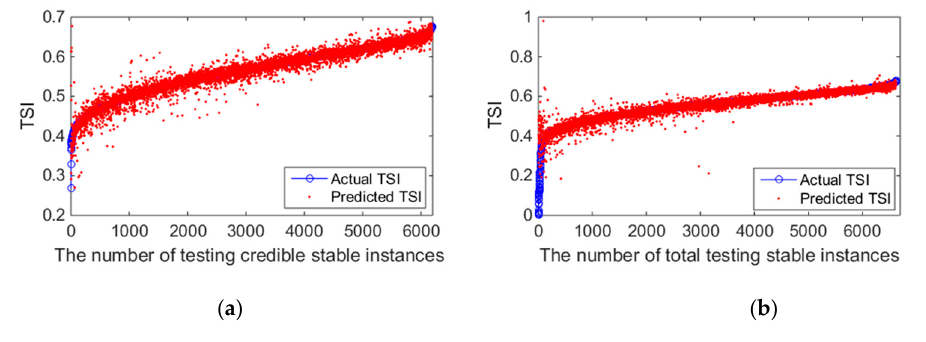
Figure 9. Detailed prediction results for the stable regression model at a response time of 0.50 s: ( a ) detailed prediction results of testing credible stable instances, mean squared error (MSE) = 0.0003; ( b ) detailed prediction results of total testing stable instances, MSE = 0.0014.